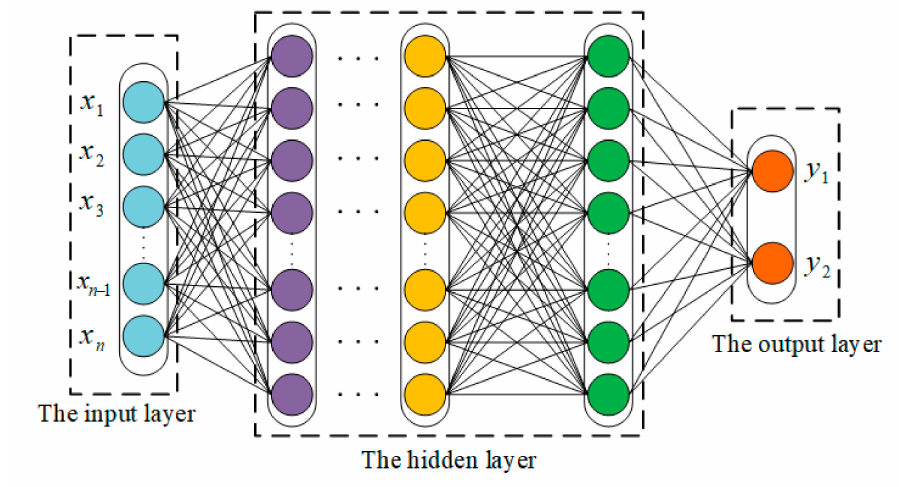
Figure 4. The structure of fully connected neural network (FCNN)